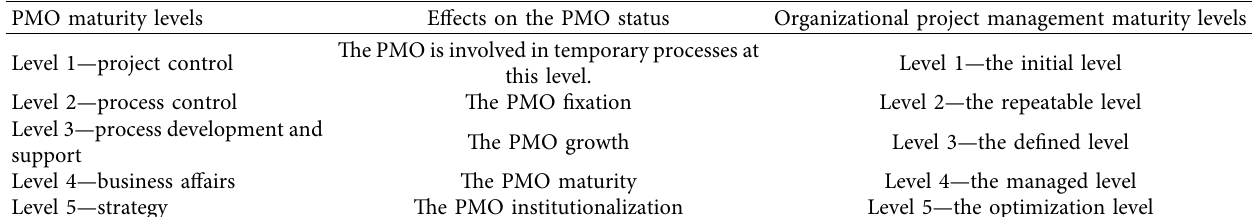
Table 1: The effects of PMO maturity levels on a project management (based on research findings).